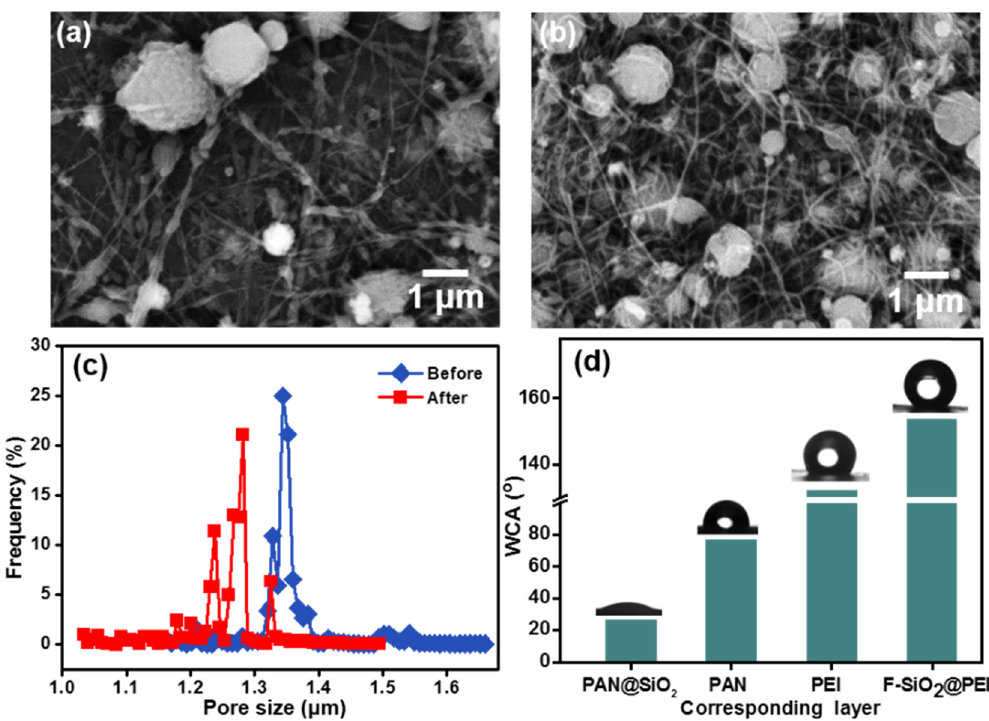
Figure 4: SEM images of PAN@SiO 2 ( a ) and F - SiO 2 @PEI skin layers ( b ) . PSD curves of the membranes with asymmetric superwettability ( c ) . WCA of the corresponding layer of the membranes ( d )